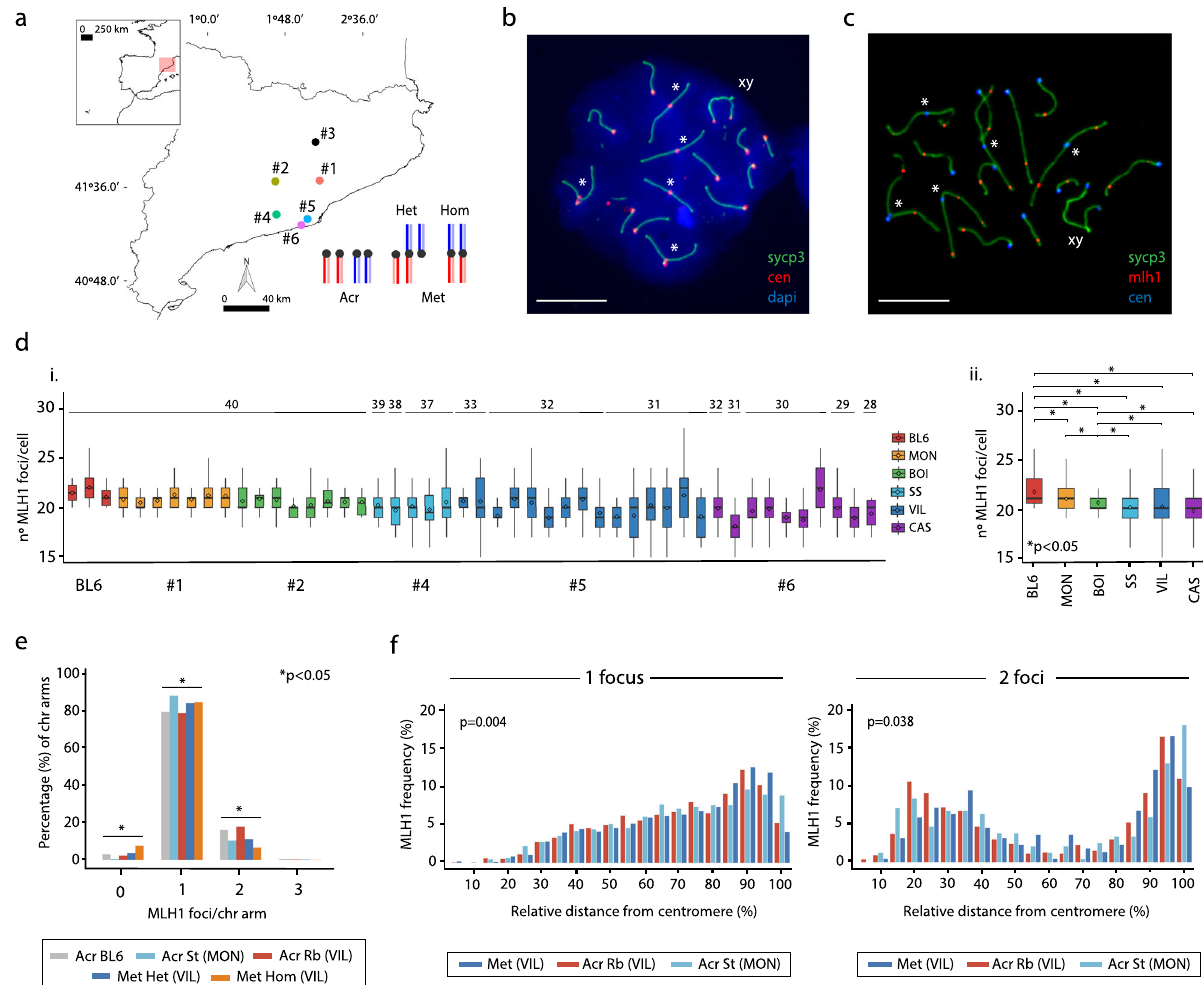
Fig. 1 Genomic landscapes of recombination. a BRbS populations sampled. See Supplementary Table 1 for the population ’ s number assignment. The diagram represents different types of chromosomal fusions. Chromosome type legend: Acr, all-acrocentric chromosomes of standard mice; Met Het, Rb chromosomes in heterozygous state of Rb mice; Met Hom, Rb chromosomes in homozygous state of Rb mice. b Immuno fl uorescence of a spermatocyte at pachytene stage from a Rb mouse (2 n = 32): SYCP3 (green), centromeres (red), and DNA (DAPI, blue). Asterisks indicate Rb chromosomal fusions. Sex chromosomes (XY) are indicated. Scale bar = 10 µ m. Immuno fl uorescence replicates, n = 3. c Immuno fl uorescence of a spermatocyte at pachytene stage: SYCP3 (green), MLH1 (red), and centromeres (blue). Asterisks indicate Rb chromosomal fusions. Sex chromosomes (XY) are indicated. Scale bar = 10 µ m. Immuno fl uorescence replicates, n = 3. d Boxplots depicting the number of MLH1 foci/cell per specimen represented (i) individually (colors correspond to panel a ) and (ii) per population. Boxplots are presented as mean values ± SD; center line, median; center diamond, mean. (i) Three laboratory mice (BL6) are included for comparison. Boxplots indicating mean values and standard deviations are shown for each individual. BRbS populations: CAS Castelldefels, BOI Castellfollit del Boix, MON Caldes de Montbuí, SS Sant Sadurní d ’ Anoia, VIL Viladecans. The diploid number of each mouse specimen is indicated on top of each boxplot. Source data are provided as a Source Data fi le. (ii) Mean numbers of MLH1 foci/cell in laboratory mice (BL6) and wild-caught standard (St) and Rb mice represented per population. P values (Wilcoxon ’ s rank-sum test followed by Dunn ’ s tests (two-sided) adjusted by Bonferroni, * P < 0.05) represent differences between populations (BL6, laboratory mice ( n = 55 cells); CAS ( n = 296 cells), BOI ( n = 174 cells), MON ( n = 174 cells), SS ( n = 206 cells), VIL ( n = 605 cells)). Source data are provided as a Source Data fi le. e Percentage of chromosomal arms showing the different number (0, 1, 2, or 3) of MLH1 foci per-chromosome ( χ 2 test, one-sided, * P < 0.05). The number of chromosome arms analyzed per arm type: n = 1046 for Acr BL6; n = 1140 for Acr St (MON); n = 2233 for Acr Rb (VIL); n = 483 for Met Het (VIL); n = 1517 for Met Hom. Source data are provided as a Source Data fi le. f Distribution of MLH1 foci along individual chromosomal arms with one (left panel) or two (right panel) MLH1 foci from panel e . The X axis represents the relative positions on the chromosomal axes from the centromere (0%) to the distal telomere (100%) ( χ 2 test, one-sided, P < 0.05). The Y axis indicates the frequency of MLH1 foci in each interval of chromosome arm length. Chromosome type legend: Acr St, all-acrocentric chromosomes of standard mice from MON population ( n = 1014 chromosomal arms with 1 CO; n = 120 chromosomal arms with 2 COs); Acr Rb, acrocentric chromosomes of Rb mice from VIL population ( n = 1232 chromosomal arms with 1 CO; n = 271 chromosomal arms with 2 COs); Met, arms of metacentric chromosomes of Rb mice from VIL population ( n = 1272 chromosomal arms with 1 CO; n = 112 chromosomal arms with 2 COs). Source data are provided as a Source Data fi le.